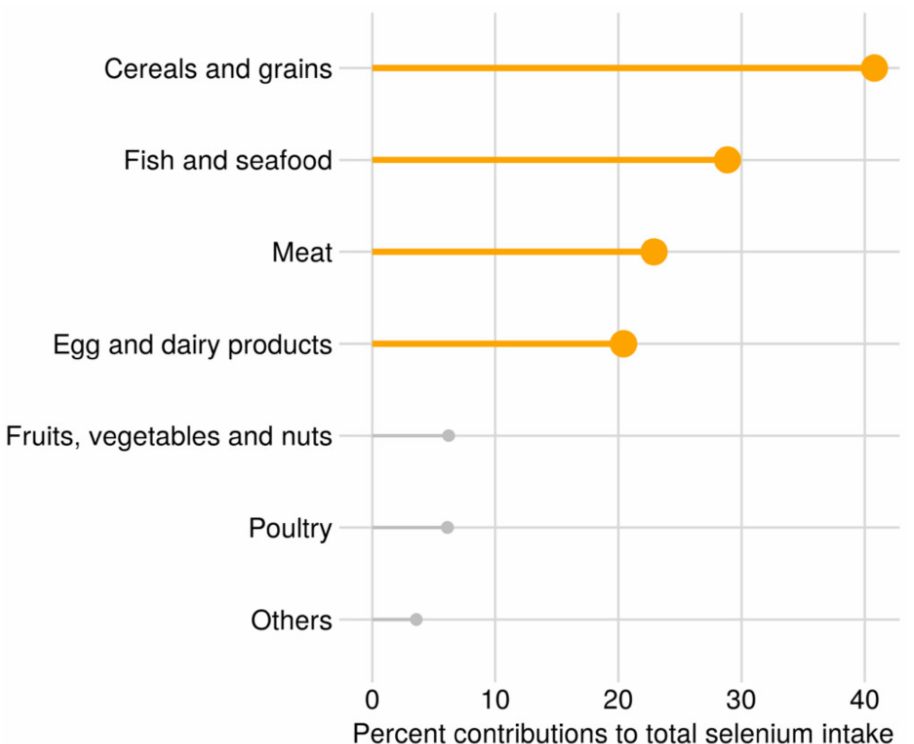
Figure 2. Sources of selenium from food, percent mean contribution to the total dietary selenium